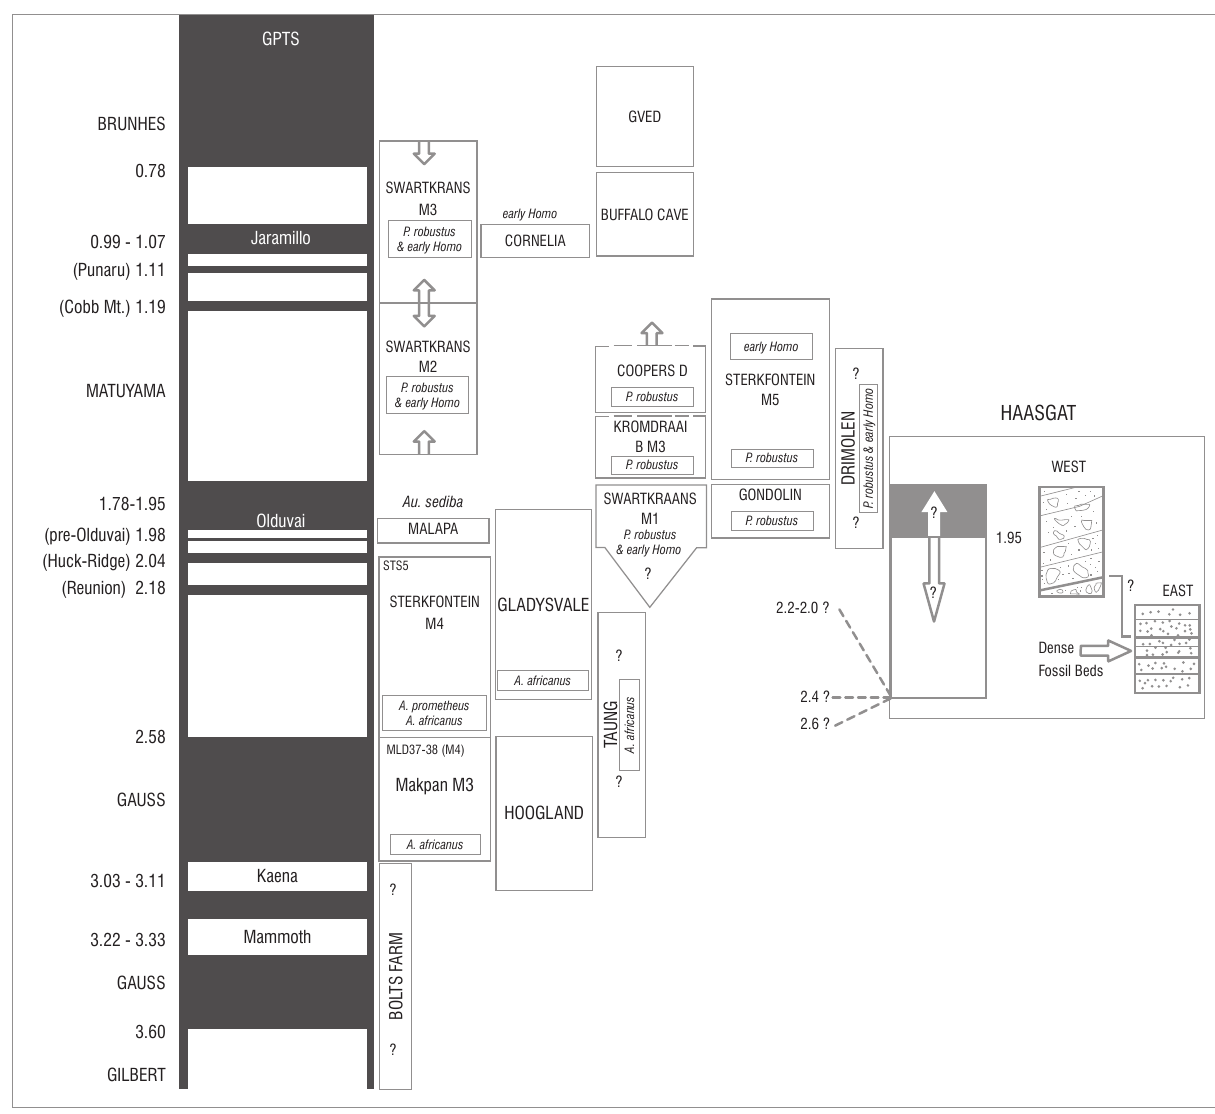
The age of Haasgat on the geomagnetic polarity timescale (GPTS) compared with other hominin and vertebrate fossil bearing